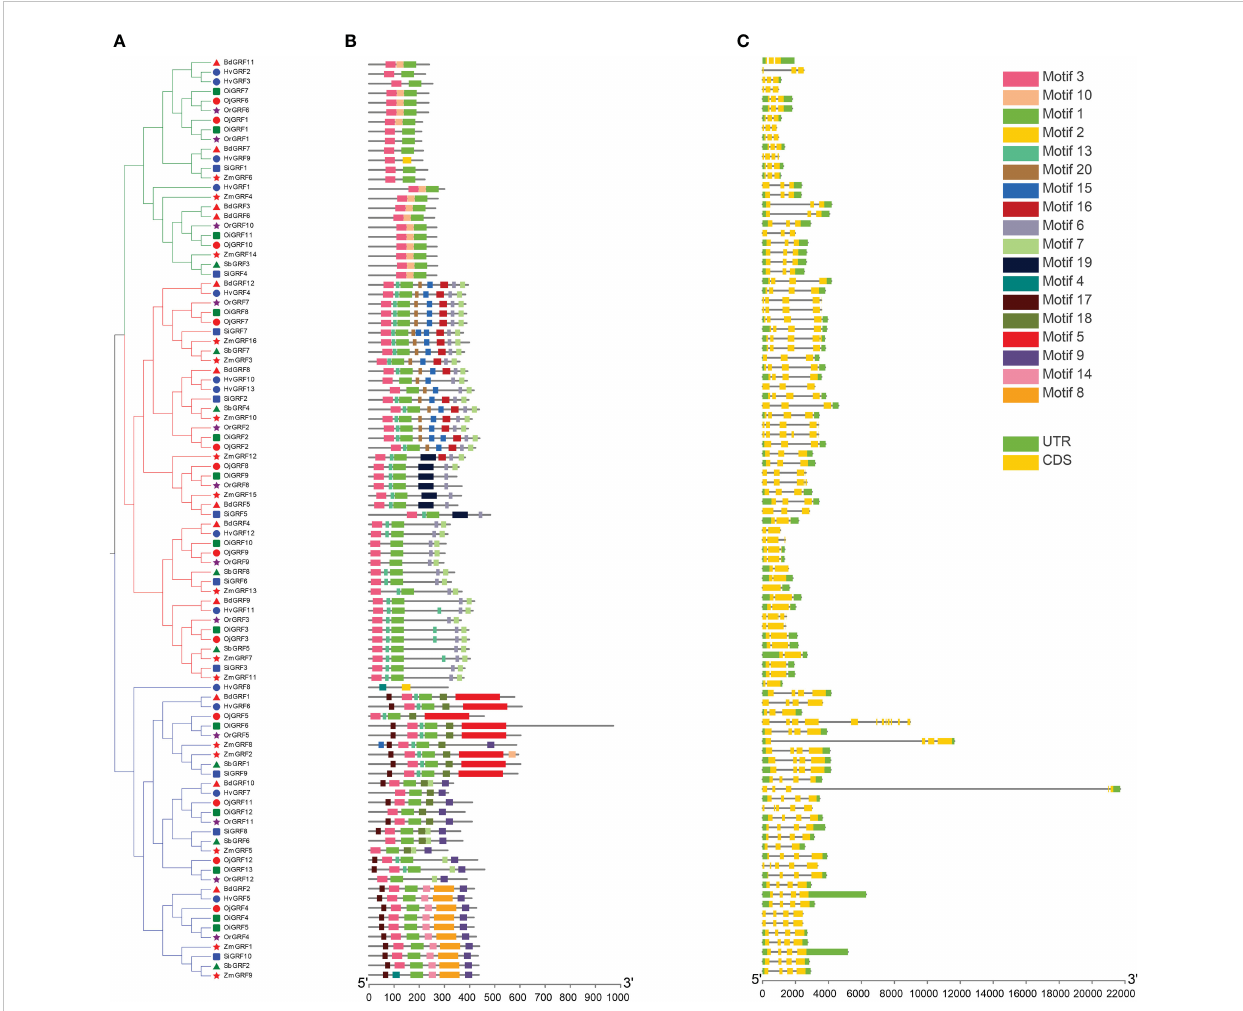
FIGURE 4 Phylogenetic relationships, gene structure, and the protein conserved motif of GRFs in eight Gramineae crops. (A) According to the NJ method in MEGA software, a phylogenetic tree of the GRF family from the eight Gramineae crops. (B) Distribution of the conserved motifs of the GRFs elucidated by TBtool Software. The different colored and numbered boxes represented different conserved motifs. (C) Exon-intron structures of GRF family. The green boxes represent exon and the gray line represents